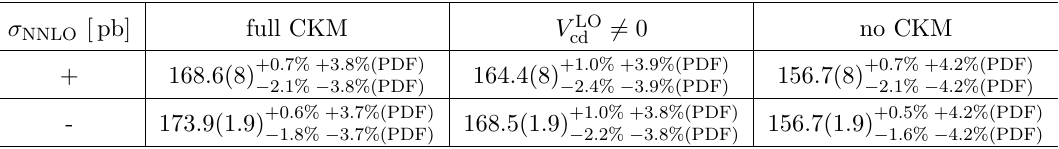
Table 3 . Fiducial cross sections with full off-diagonal CKM dependence ( full CKM ), with only V cd 6 = 0 at LO ( V LO 6 = 0 ), and with no off-diagonal dependence ( no CKM ). All predictions are cd at NNLO QCD accuracy and are shown for both the pp → W + j and pp → W − j process at c c √ s = 13 TeV. The digit in parenthesis indicates the Monte Carlo statistical error while the sub- and super-script in per cent indicate the scale variation. In addition, the PDF variation is also provided for the NNLO NNPDF3.1 set with α = 0 . 118 s